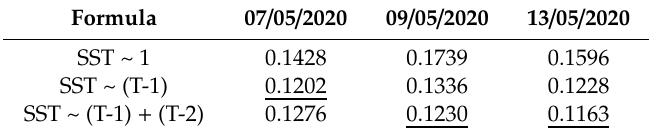
Table 2. Interpolation validation results from the RMSE index. Best results are